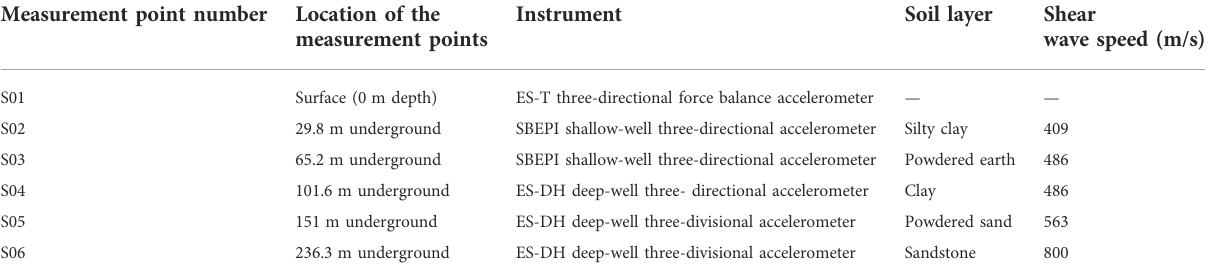
TABLE 1 Information on the instrument